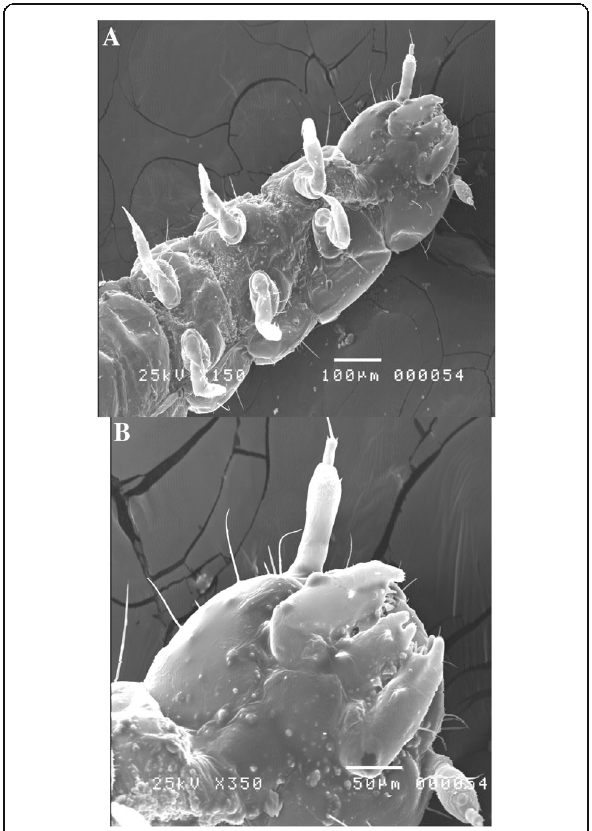
Fig. 8 a SEM of ventral view of the first larval instar of T. confusum showing the head, thorax, and the legs. b Higher magnification of the ventral view of the first larval instar of T. confusum showing its mouth parts and